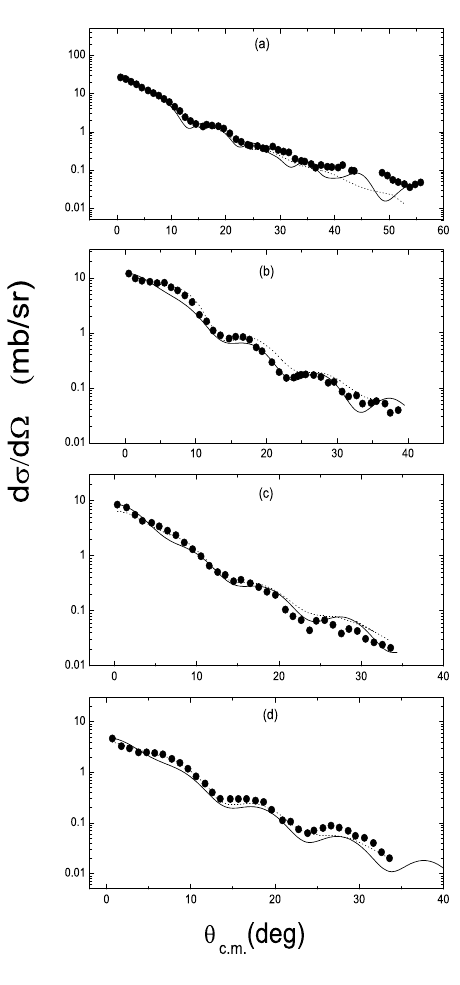
Figure 2. The calculated di ff erential cross sections for the 9 Be( 10 B , 9 Be) 10 B reaction. The points are the experimental data taken from [5]. The solid and dashed lines are the results of the present work and the DWBA calculations of [5], respectively, for the ground ( a ), first (( b ) for E ∗ = 0.718 MeV), second (( c ) for E ∗ = 1.740 MeV) and third (( d ) for E ∗ = 2.154 MeV) excited states of 10